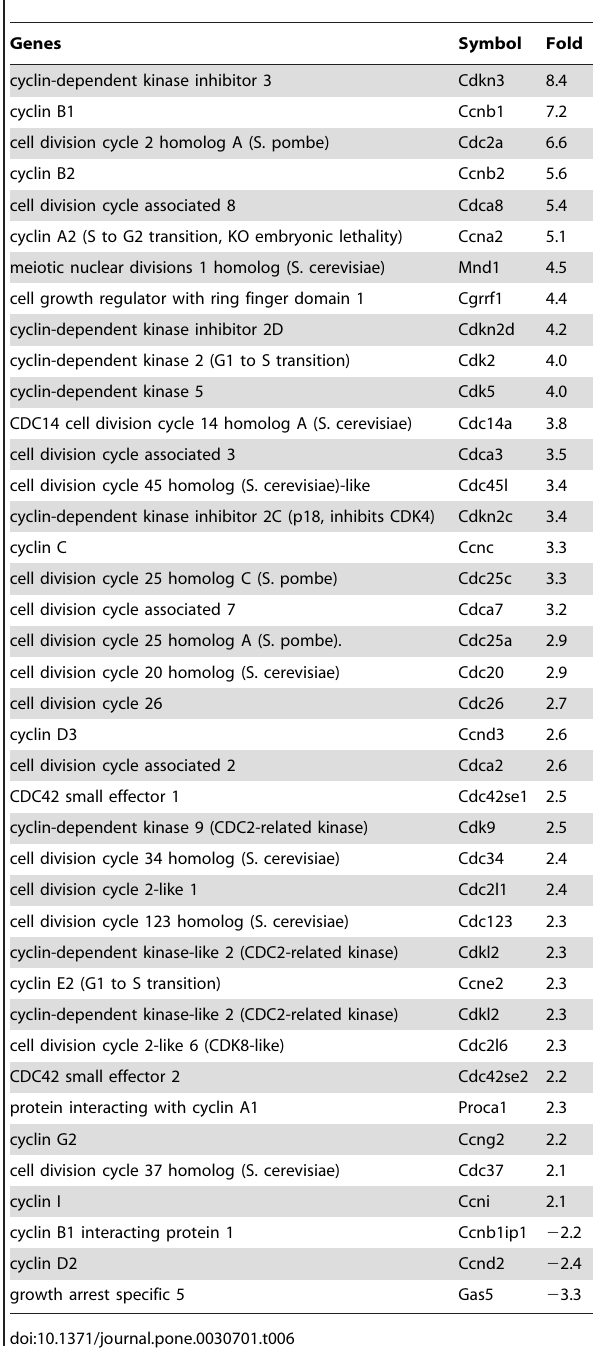
Table 5. Decreases of monomeric low-molecular-weight Ras GTPase superfamily in lal 2 / 2 bone marrow MDSCs.